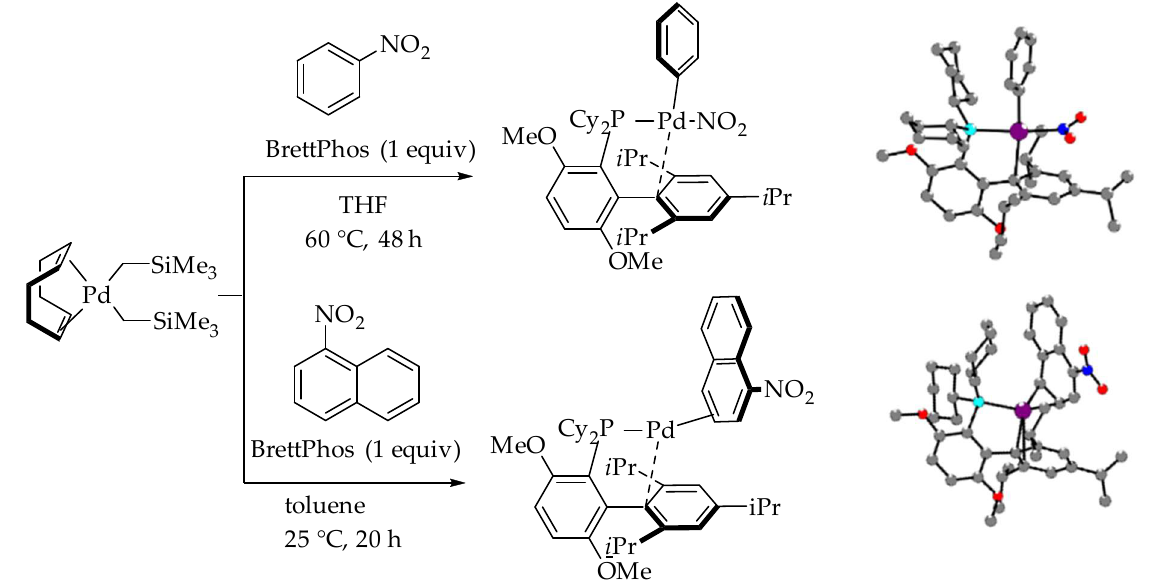
Figure 3. Reaction of Brett-Phos-Pd(0) with nitrobenzene and 1-nitronaphtalene. Crystal structure of Pd-complex obtained by single-crystal X-ray diffraction. Color code: C in grey, O in red, N in blue, P in cyan, Pd in purple [24].